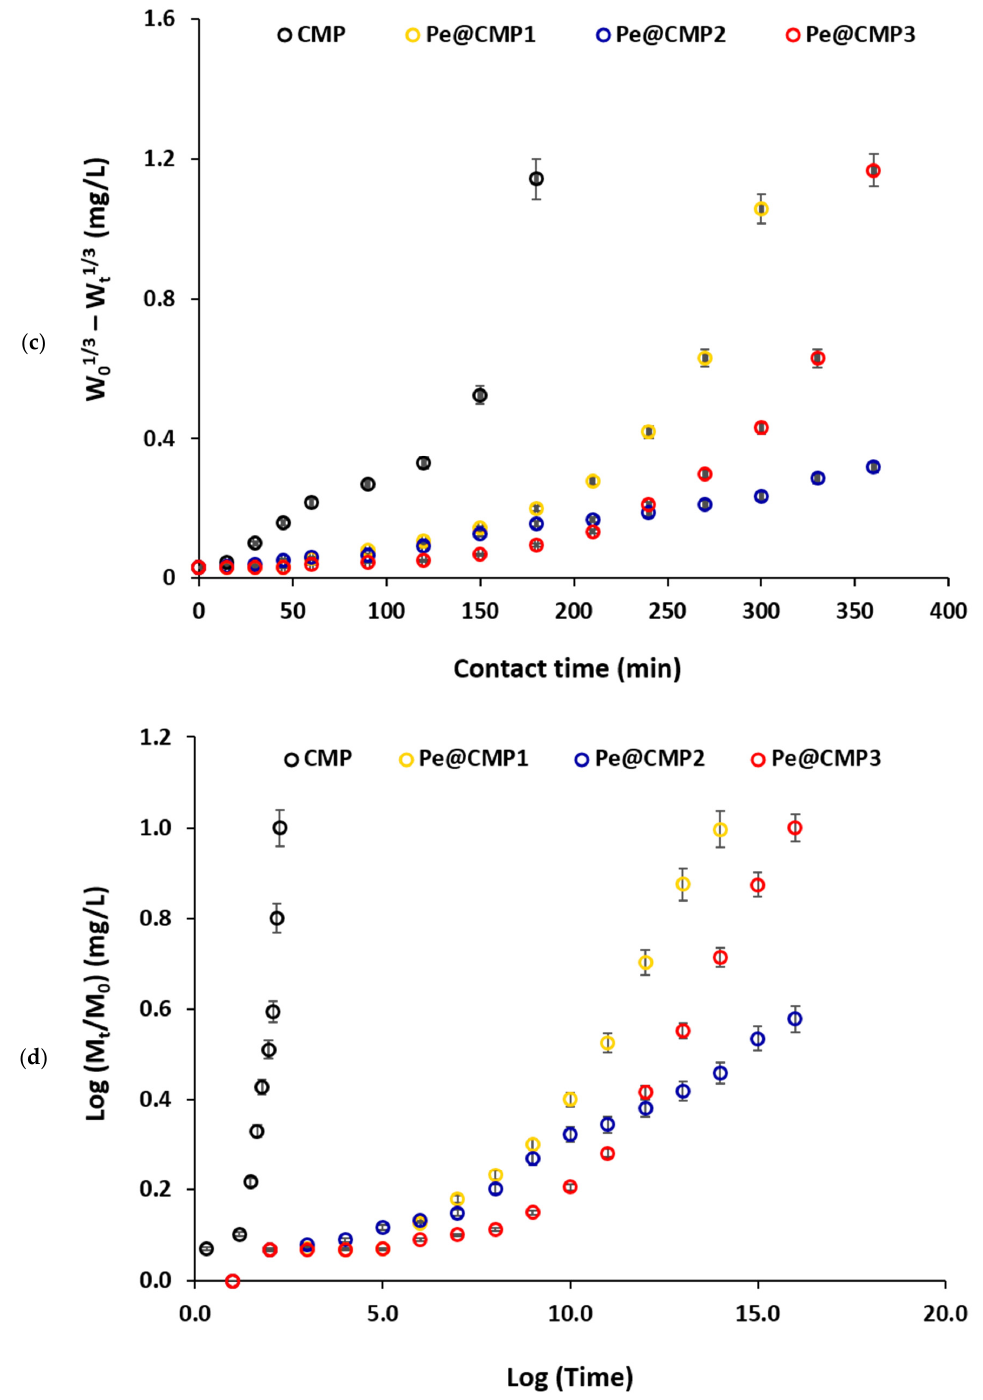
Figure 8. Kinetics for the release of PI from CMP and Pe@CMP hydrogel; ( a ) First, order fitting, ( b ) Higuchi, ( c ) Hixson–Crowell and ( d ) Krosmeyer–Peppas.